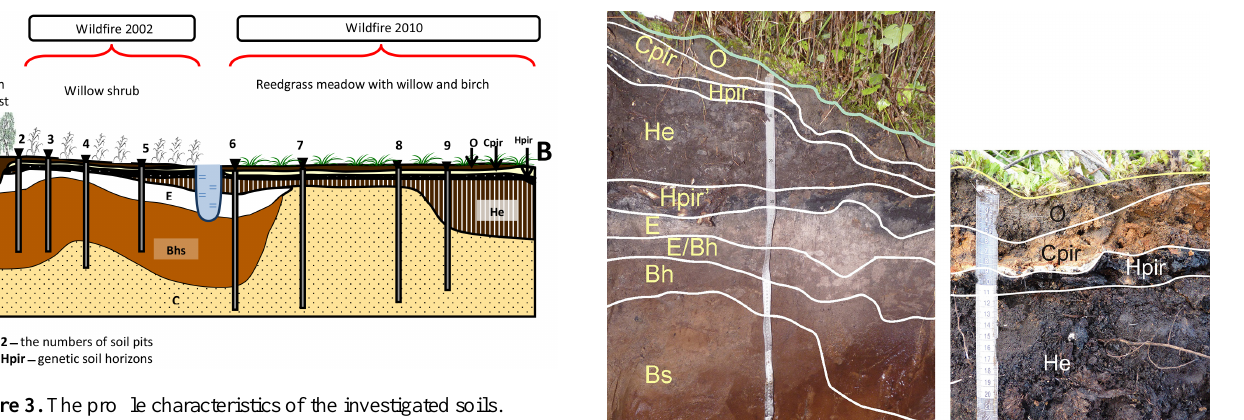
Figure 3. The profile characteristics of the investigated soils.